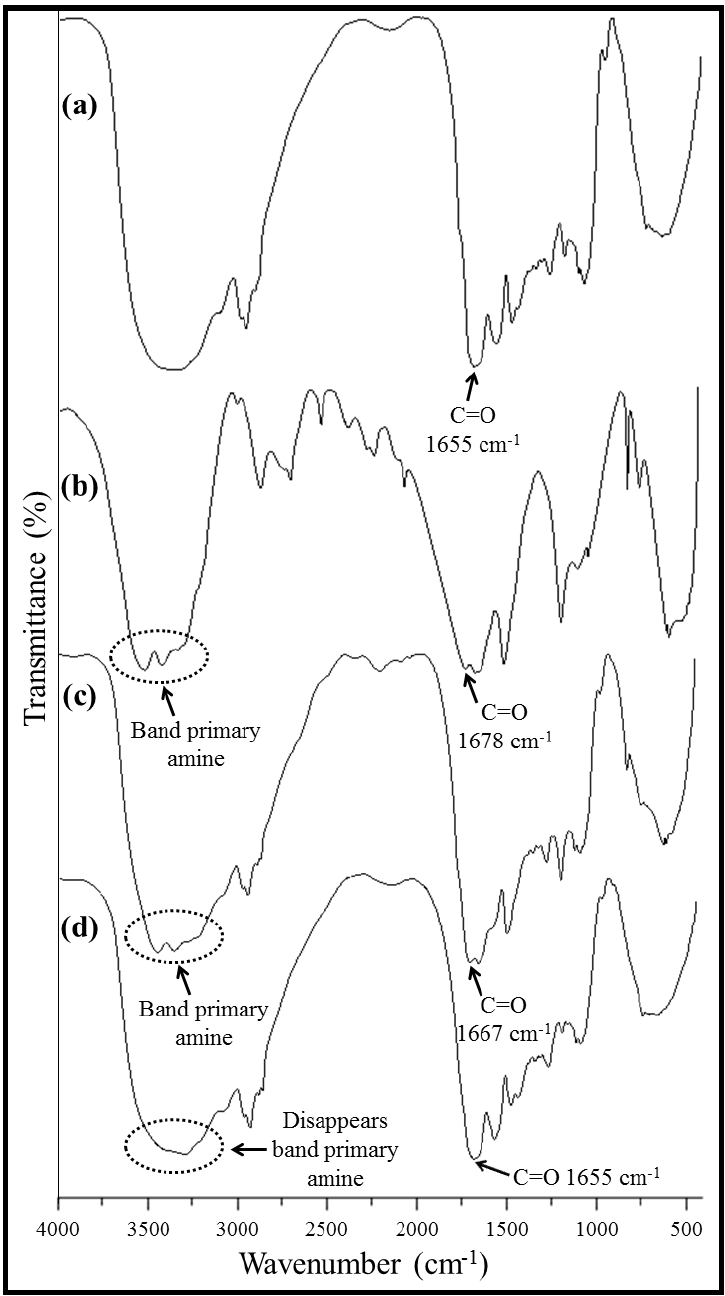
Figure 3. FT-IR spectra of ( a ) pastille composed of WG membranes loaded with water; ( b ) urea powder; ( c ) pastille composed of WG membranes loaded with urea; and ( d ) pastille composed of WG membranes loaded with urea after the release test. All pastilles were freeze-dried before